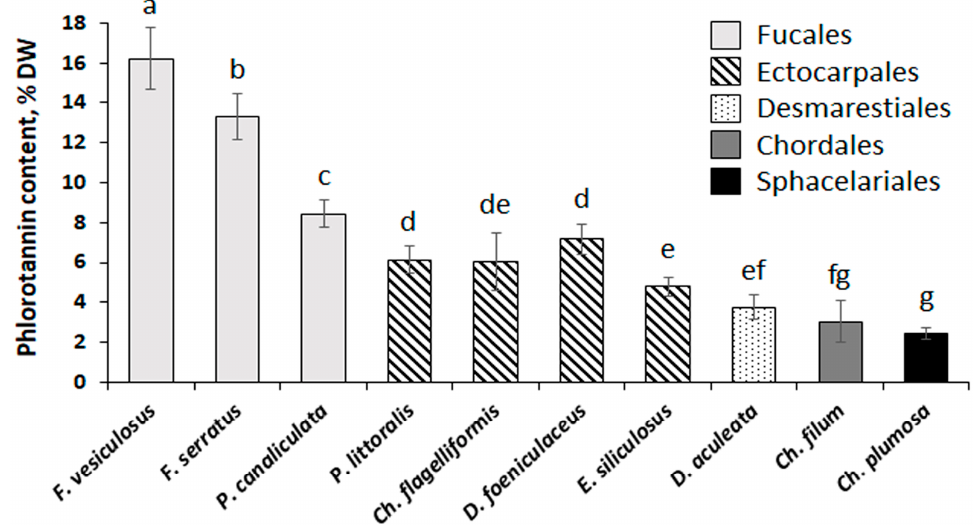
Figure 2. Content of phlorotannins in the algae representing five orders of Phaeophyceae (Fucales, Ectocarpales, Desmarestiales, Chordales, and Sphacelariales). Bars represent the mean ± SD ( n = 6– 12). Different letters indicate significant differences ( p < 0.05, Student’s t